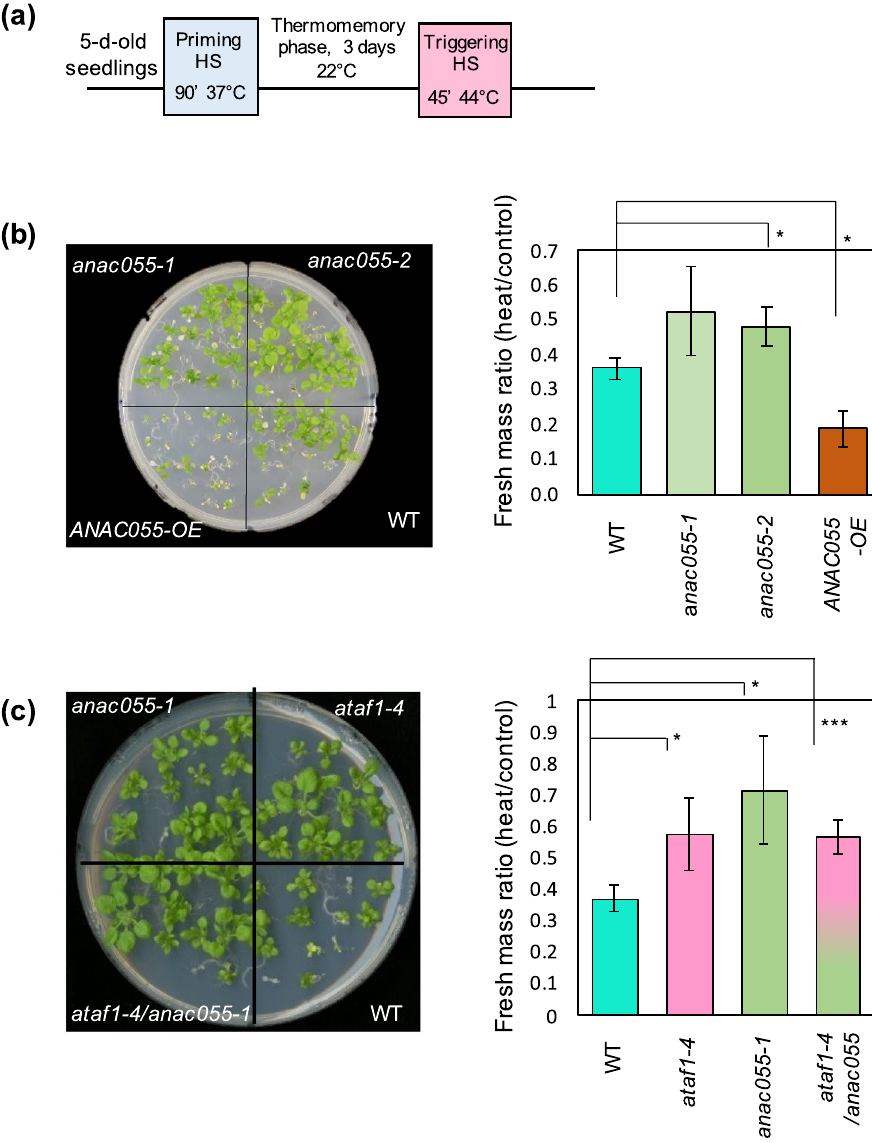
Figure 7. Thermomemory is improved in the ataf1–4 / anac055 double-knockout mutant compared to WT. ( a ) Schematic representation of HS regime. ( b ) Thermomemory phenotype of ANAC055- OE, anac055-1 and anac055-2 mutants, and WT plants. ( c ) Thermomemory phenotype of ATAF1 -OE, ataf1–4 mutant, ataf1– 4 / anac0 55 double-mutant, and WT plants. Seedlings were exposed to the HS regime shown in ( a ). Left panels: seedlings photographed 14 days after exposure to the triggering heat stress. The phenotype of one representative replicate of at least three ( b ) or five ( c ) independent biological replicates is shown. Right panels: seedling fresh mass upon heat stress, compared to control plants (no heat stress). Error bars represent standard deviation, which was calculated from three biological replicates, where each replicate was the average mass of 18–19 seedlings. Significant differences between transgenic lines and WT plants were calculated using Student’s t -test; * if P < 0.05; *** if P <